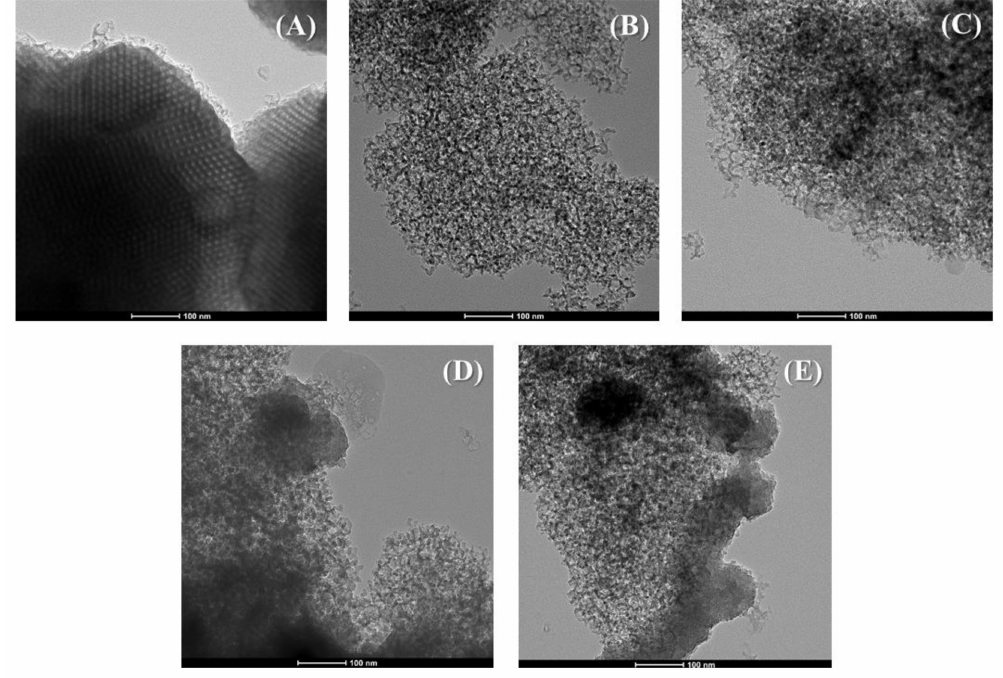
Figure 2. TEM micrographs of the traditional SBA-15 ( A ), Si ( B ), SiZr20 ( C ), SiZr10 ( D ) and SiZr5 ( E ) samples. In order to determine the textural properties of the porous silica and the Zr-doped porous silica, N 2 adsorption–desorption analyses at − 196 ◦ C were carried out (Figure S2A). According to the IUPAC classification, all isotherms can be considered as type IV,